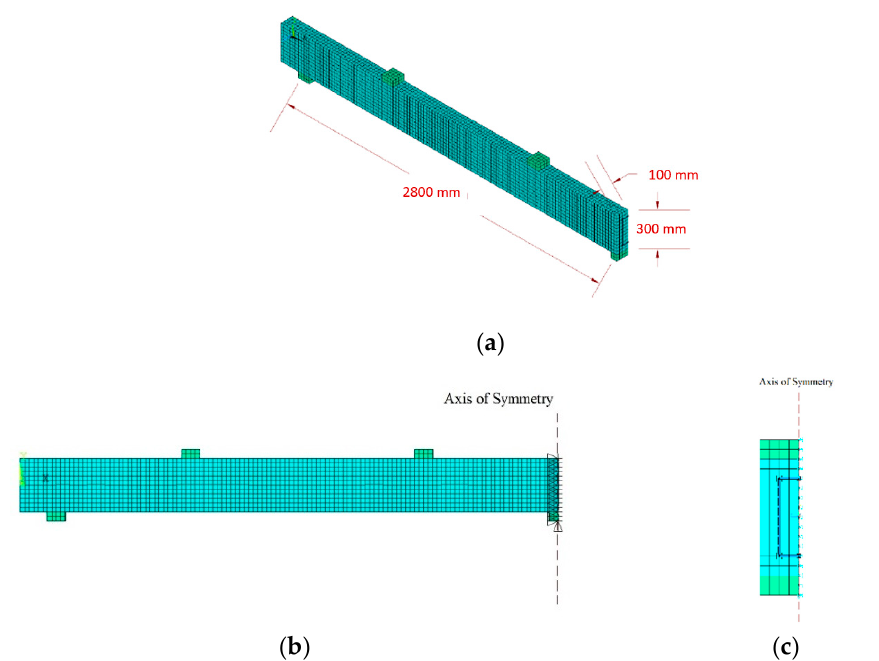
Figure 4. Typical schematic diagrams for ( a ) Isometric view of longitudinal span of beam model, ( b ) Axis of symmetry at middle support with appropriate boundary conditions, and ( c ) Axis of symmetry along the beam’s cross-section with boundary